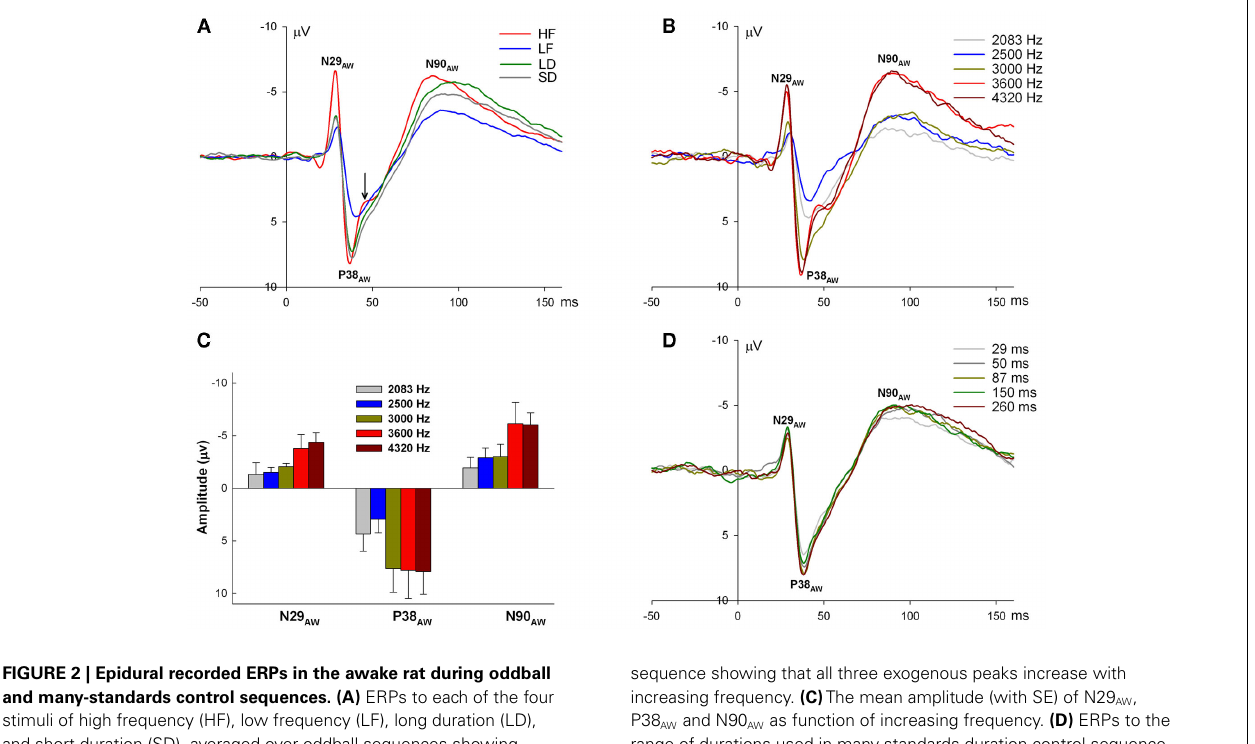
FIGURE 2 | Epidural recorded ERPs in the awake rat during oddball and many-standards control sequences. (A) ERPs to each of the four stimuli of high frequency (HF), low frequency (LF), long duration (LD), and short duration (SD), averaged over oddball sequences showing three exogenous peaks N29 AW , P38 AW , and N90 AW .The arrow indicates the notch in the HF ERP between P38 AW and N90 AW . (B) ERPs to the range of frequencies used in the many-standards frequency control